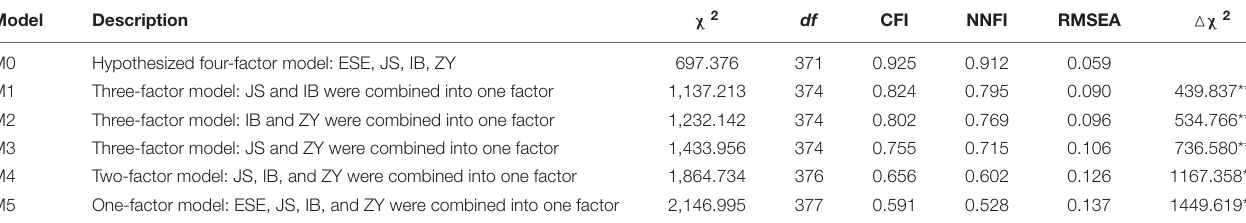
TABLE 2 | Confirmatory factor analysis by comparing alternative measurement